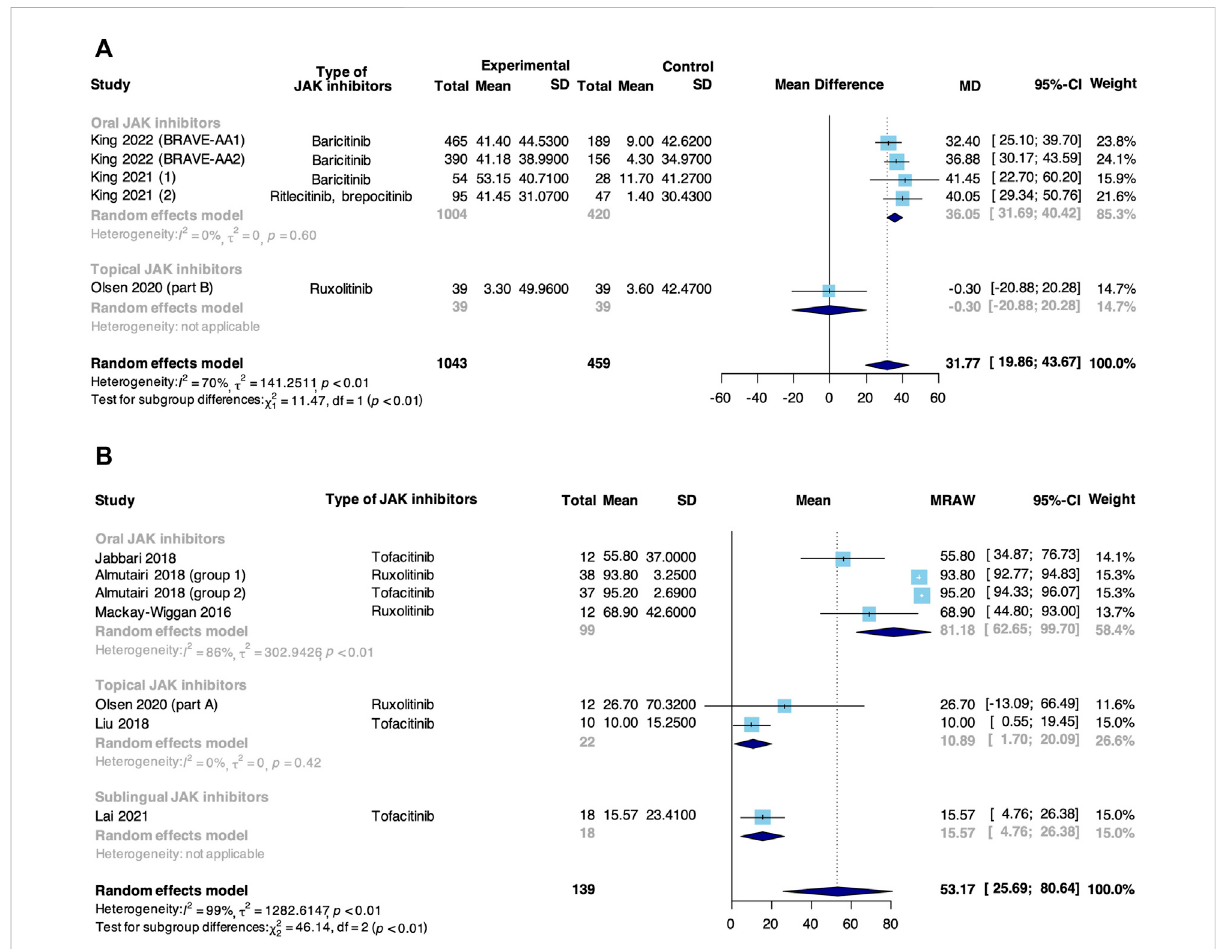
FIGURE 4 Forest plot of the percent change from baseline in SALT score in patients taking JAK inhibitors for AA based on (A) RCTs and (B)